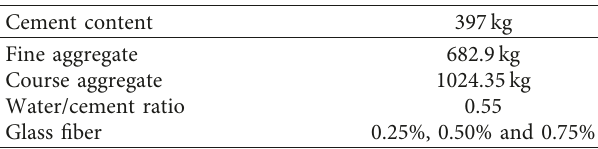
Figure 1: (a) Glass fibers preparation, (b) glass fibers ready for use. Table 1: C25 grade of concrete quantity per 1m 3 by volume for mix of